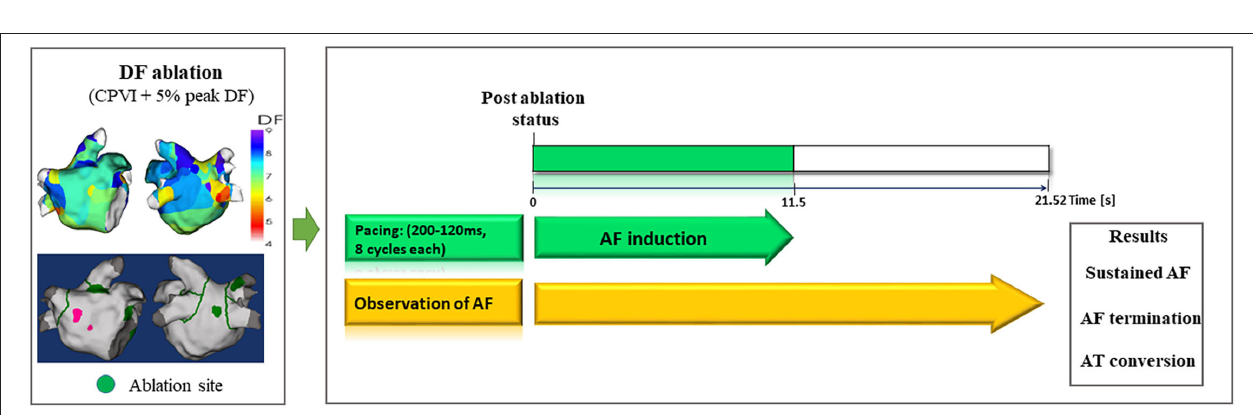
FIGURE 3 | Study protocol of computational virtual DF ablation and AF induction on postablation status. DF, dominant frequency; AF, atrial fibrillation; AT, atrial